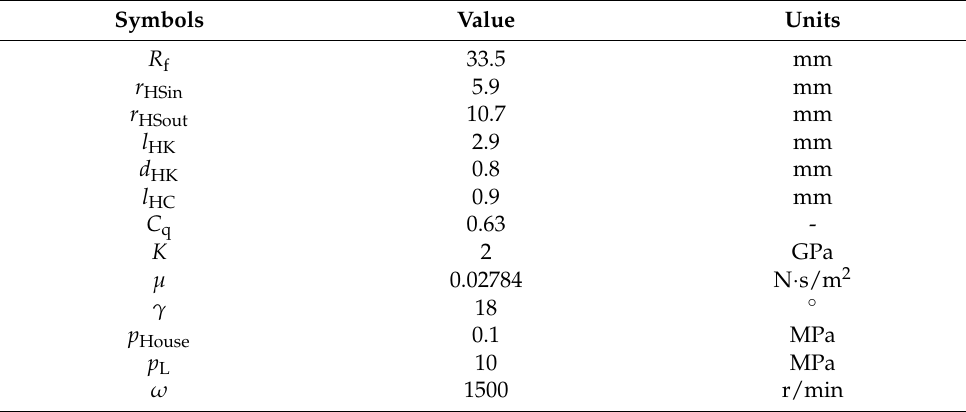
Figure 8. Slipper structure diagram, where ( a ) is without micro-chamfering; ( b ) is with micro-chamfering. Table 1. Parameters used in the lubrication model.